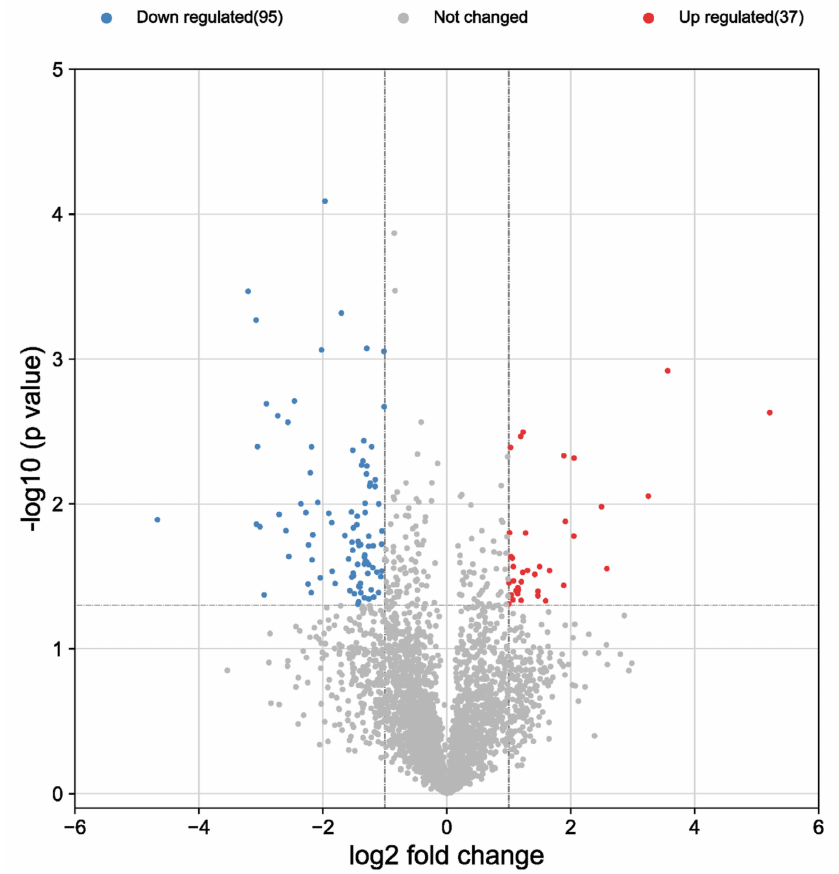
Figure 2. Volcano plot showing all proteins identified in the dataset. Human dermal fibroblasts (HDFs) were treated with Endoret Serum (ES) extract and with leukocyte- and platelet-rich plasma (L-PRP) supernatant. The X-axis represents the log 2 (fold change), and the Y-axis represents the − log 10 ( p -value). Dashed horizontal line indicates the p -value cutoff ( p < 0.05), and the two vertical dashed lines delimit downregulated (blue dots) and upregulated (red dots) proteins. The ratio is L-PRP/ES. Red dots indicate upregulated proteins in L-PRP (fold change > 2.0 and p < 0.05). Blue dots show downregulated proteins in L-PRP (fold change < 2.0 and p < 0.05). The grey dots represent proteins that do not satisfy the above